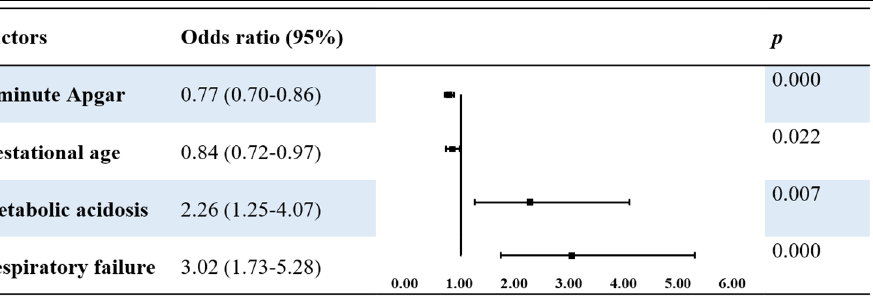
TABLE 5 Multivariable logistic analysis of risk factors of neurological injury in patients with